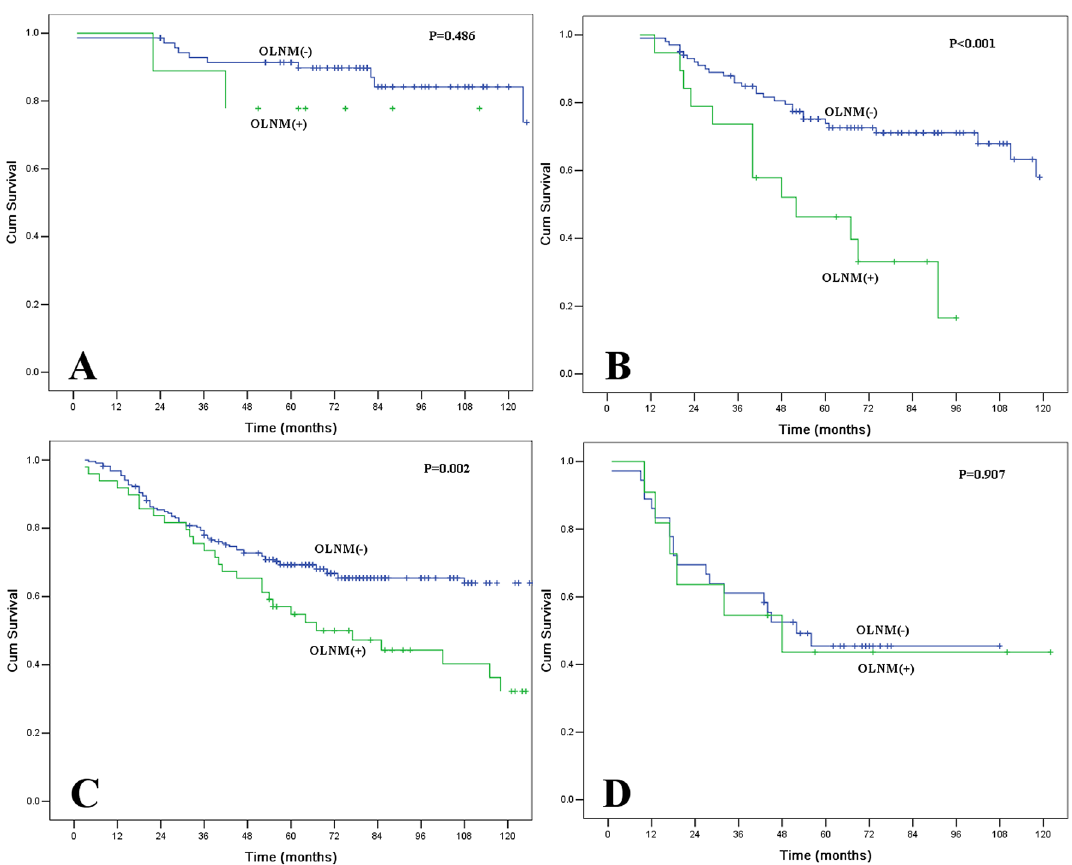
Figure 4. ( A ) The impact of occult lymph node metastasis (OLNM) on patients with pT1 category. The difference in overall survival was not significant (P = 0.486). ( B ) The impact of OLNM on patients with pT2 category. The difference in overall survival was significant (P < 0.001). ( C ) The impact of OLNM on patients with pT3 category. The difference in overall survival was significant (P = 0.002). ( D ) The impact of OLNM on patients with pT4 category. The difference in overall survival was not significant (P =